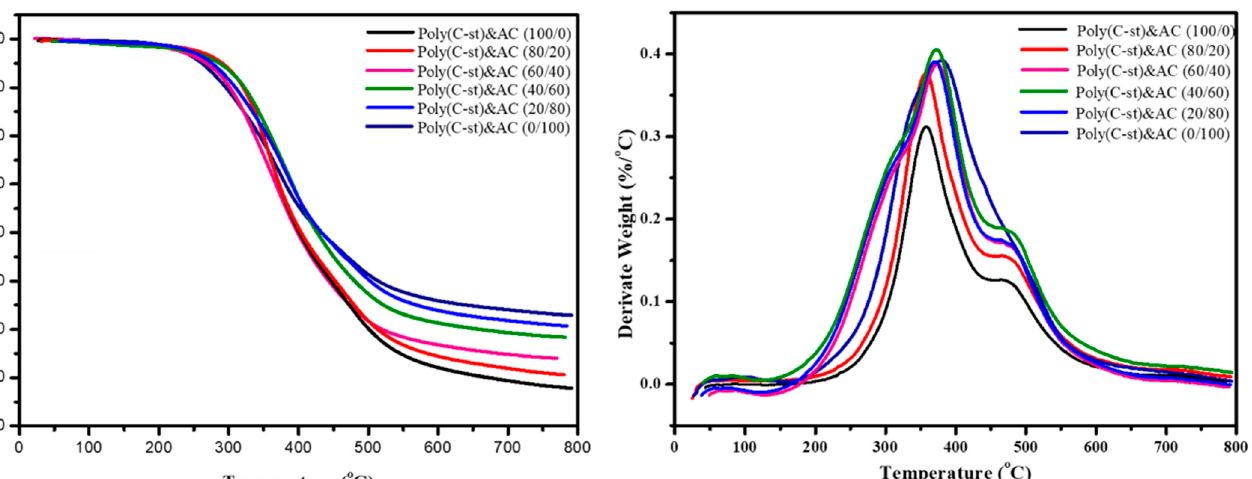
Figure 5. Stress–strain curves of poly(C ‐ st)/AC films.